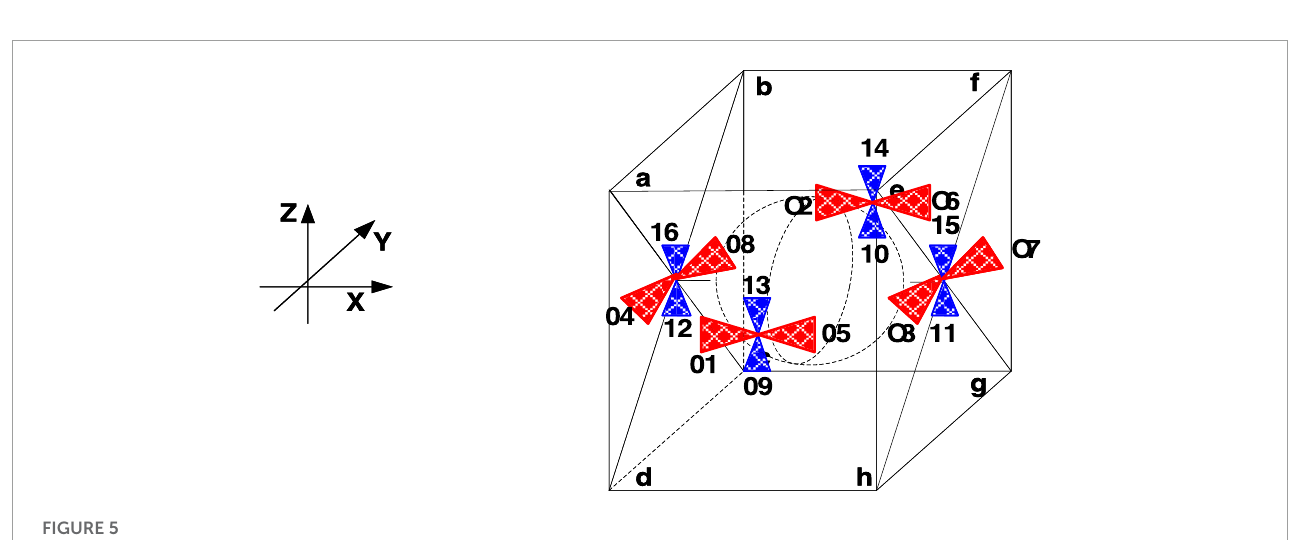
FIGURE 5 Symmetric thruster configuration